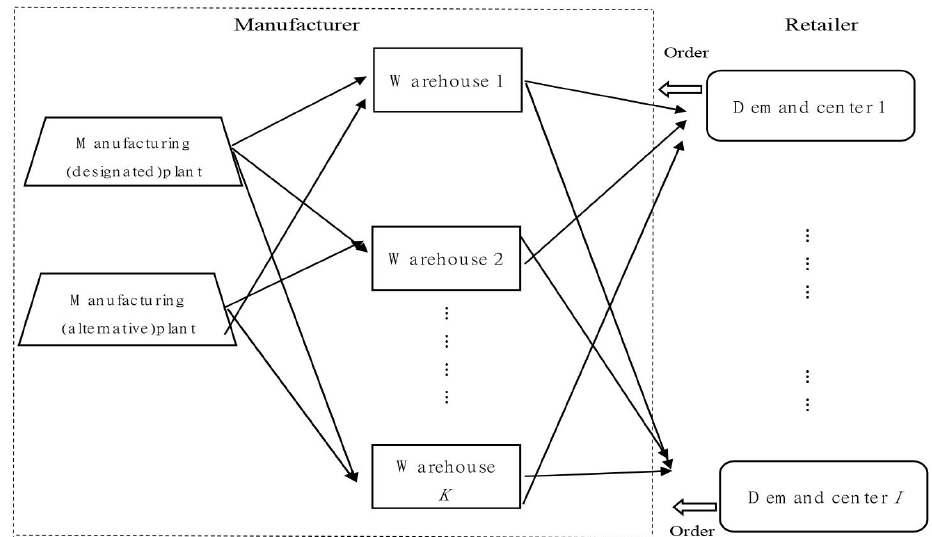
Figure 1. Spare parts supply chain network